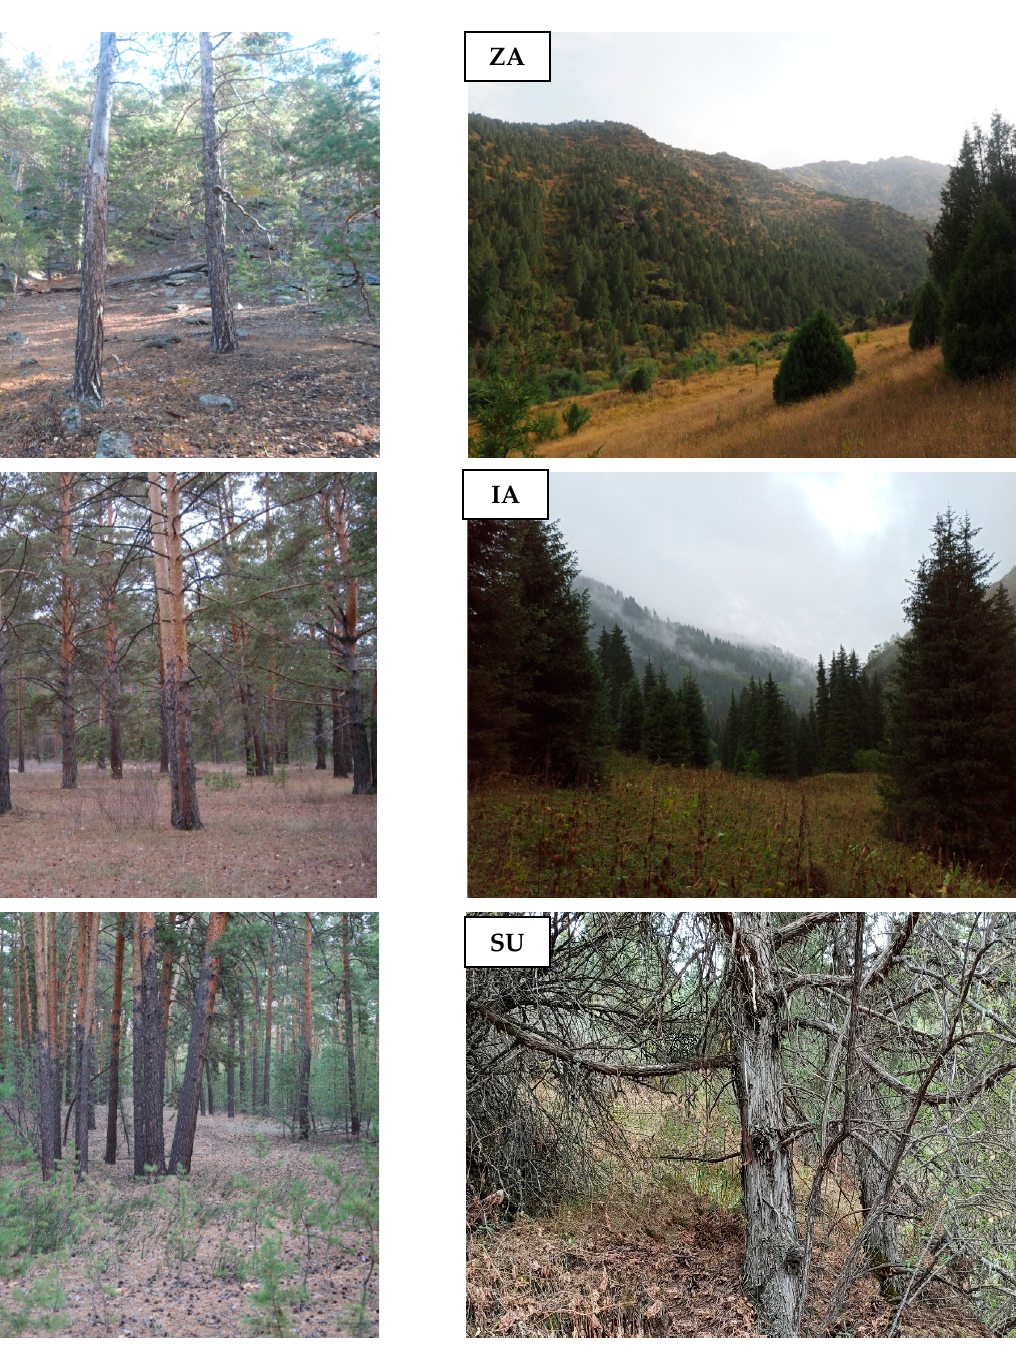
Figure A1. The sampling sites (Ba—Bayanaul, Sh—Shalday, Be—Beskaragay, ZA—Zhongar-Alatau, IA—Ile-Alatau, and SU—Sairam-Ugam).